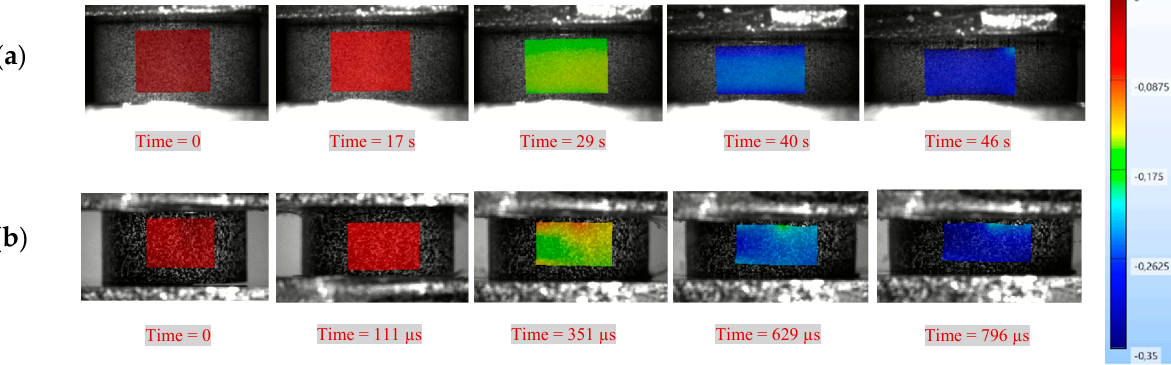
Figure 10. Evolution of the barreling ratio during compression tests at different strain rates.